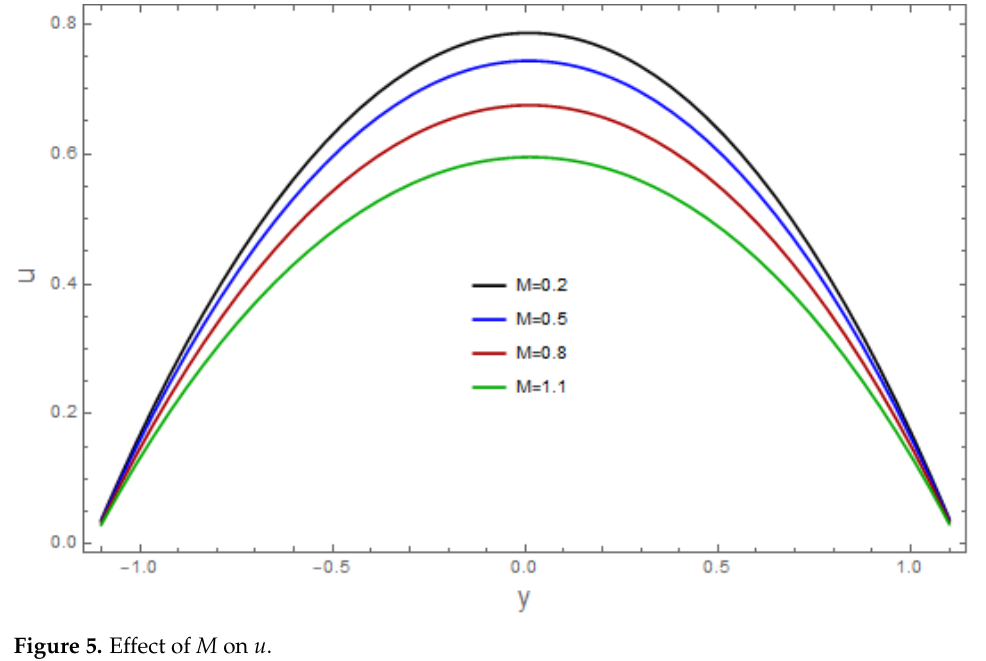
Figure 5. Effect of 𝑀 on 𝑢 .